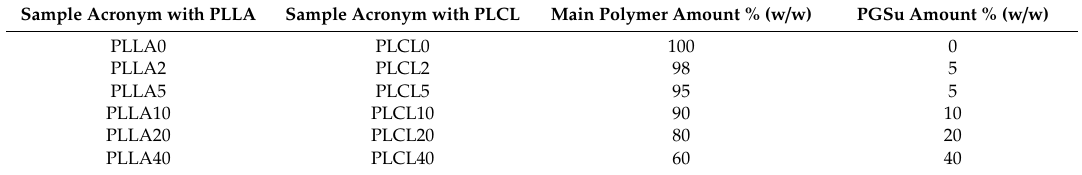
Table 1. Samples acronyms. PLCL: poly (L-lactide-co-caprolactone), PLLA: poly(L-lactic acid). Sample Acronym with